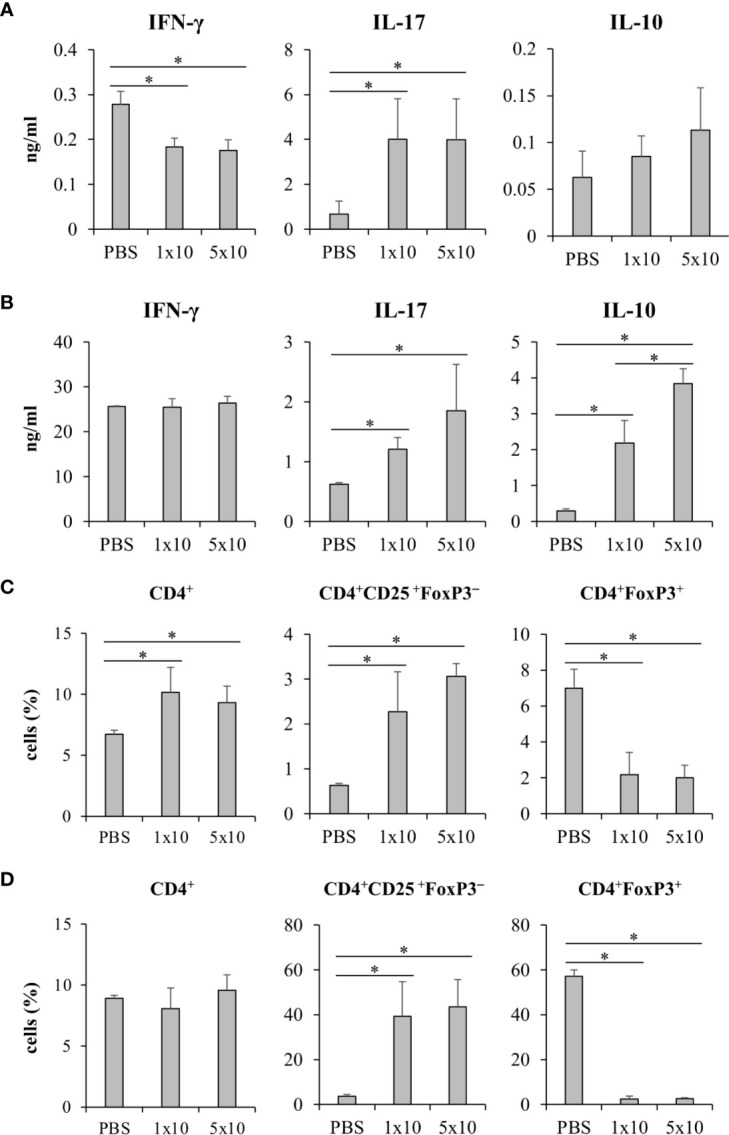
Systemic C. krusei infection promoted IL-10 production. Mice were treated with dexamethasone to induce immunosuppression and were systemically infected with 1x106 and 5x106 of C. krusei. Serum and spleens were collected on day 7 post-infection. Splenocytes were re-stimulated with immobilized anti-CD3 for 48 h. (A) Serum cytokines. (B) Cytokines from supernatant from anti-CD3-stimulated splenocytes. (C) T cells from unstimulated splenocytes. (D) T cells from anti-CD3 stimulated splenocytes. n = 5. *p < 0.05.